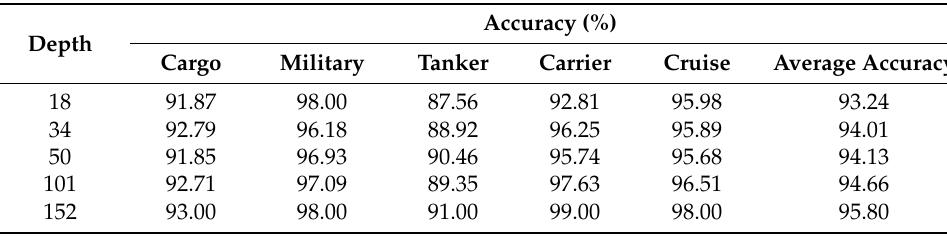
Table 3. The accuracy performance of different depth layers in our dataset.